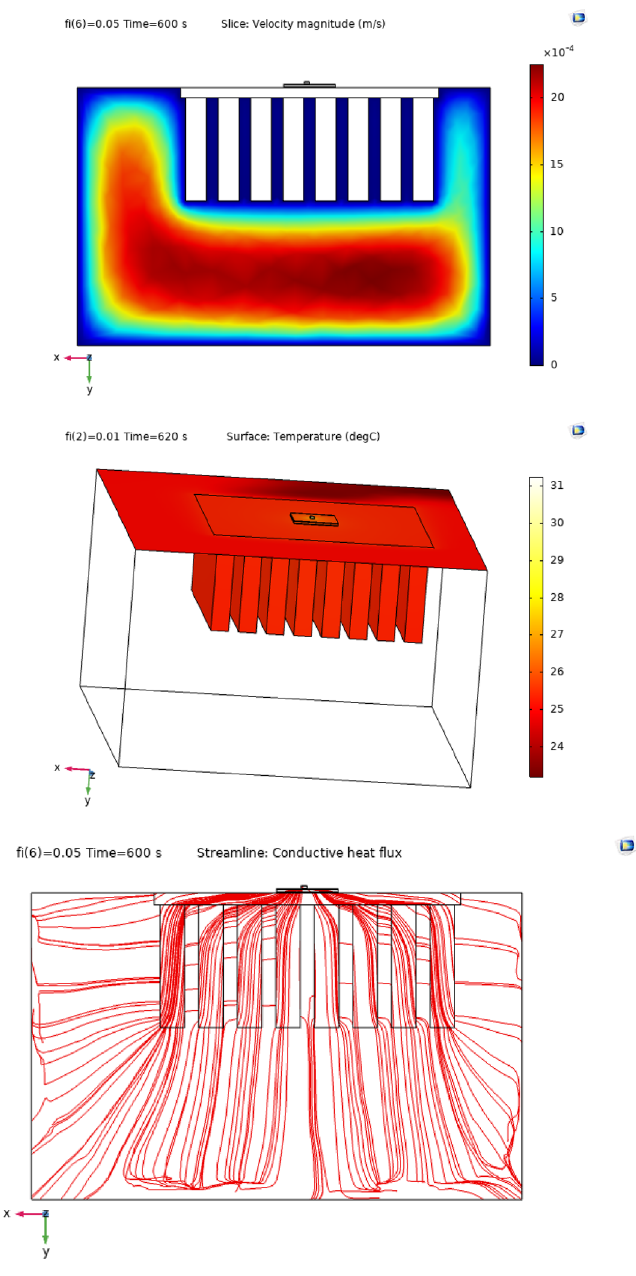
Figure 15. Velocity, temperature and streamline for optimized case (COMSOL Multiphysics 5.6, https:// www. comsol.